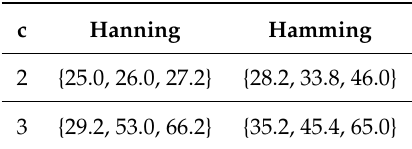
Figure 2. Illustration of the second harmonic interference. The red and blue lines are second harmonic interferences at different frequencies. The image second harmonic component is ignored. Only one bin used in the IpD 2 FT is illustrated. Table 1. Optimal DTFT frequency sets for different windows and window lengths with f = f 0 . The sampling frequency is set at 2000 Hz (for 50-Hz